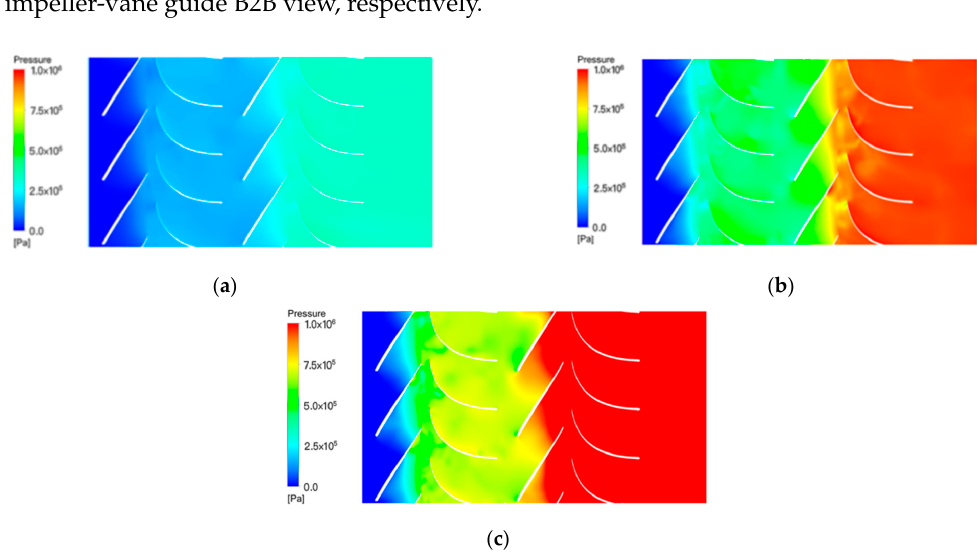
Figure 18. Influence of different inlet flow rates on pump performance.